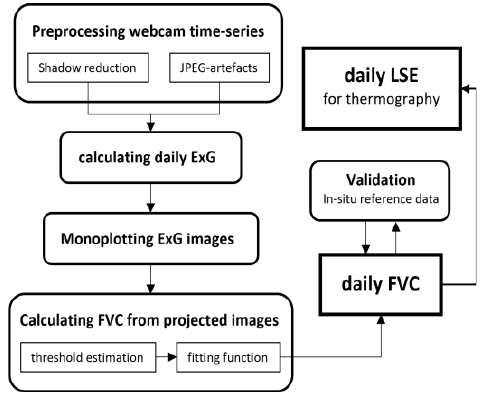
Figure 3. Preprocessed RGB composite of Mt. Schrankogel from the webcam below Mt. Wannenkogel. The 95th percentile of the daily time series of the intensity values for each band has been calculated for a shadow-minimized RGB image (10/08/2021). In the center of the image, the two large boulder fields are